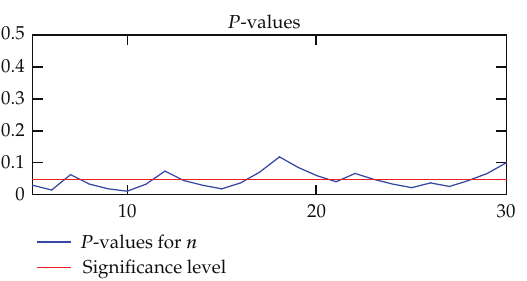
Figure 1: P values of 30 partial samples with π (cid:6) 0 . 55 and H 0 : π (cid:6) 0 . 50. The partial samples 1 to n are given on the abscissa, on the ordinate the corresponding P values. The red line indicates the significance level of